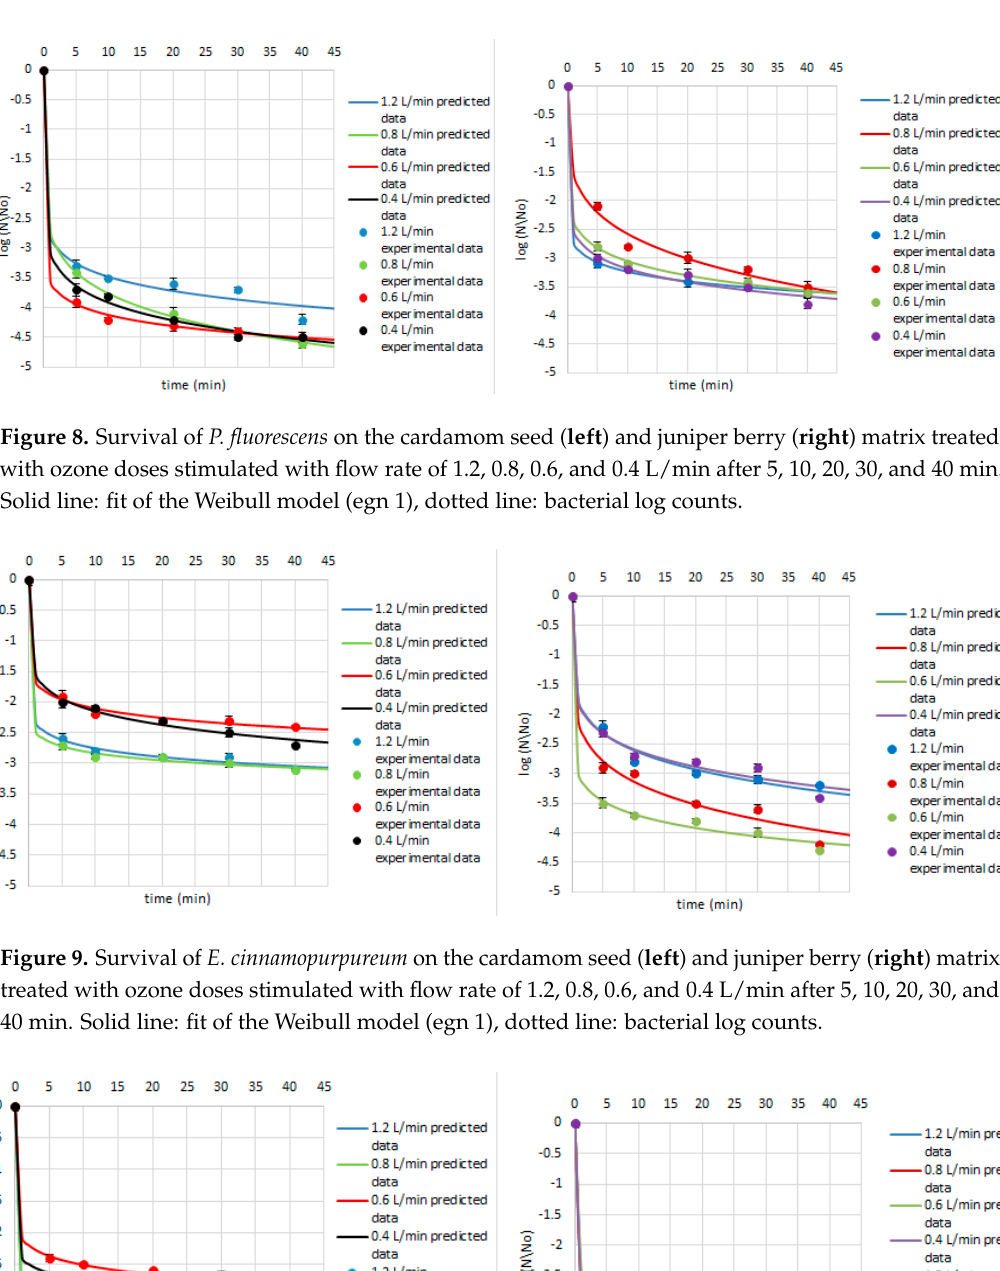
Figure 7. Survival of E. coli on the cardamom seed ( left ) and juniper berry ( right ) matrix treated with ozone doses stimulated with flow rate of 1.2, 0.8, 0.6, and 0.4 L/min after 5, 10, 20, 30, and 40 min. Solid line: fit of the Weibull model (egn 1), dotted line: bacterial log counts.